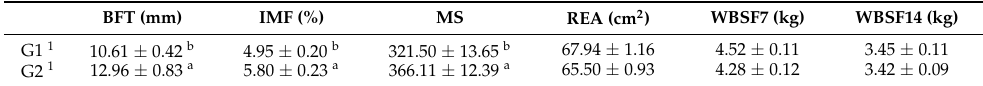
Table 2. Means and respective standard errors of carcass backfat thickness and rib eye area, fat percentage, marbling index, and shear force at 7 and 14 days of aging obtained for the two